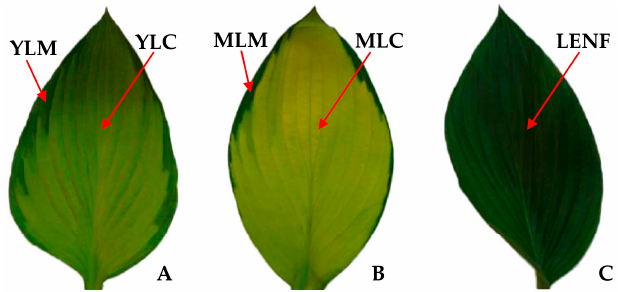
Figure 1. Representative leaves at different development stages of Hosta “Gold Standard”. ( A ) Young leaf; ( B ) mature leaf; ( C ) leaf under excess nitrogen fertilization. YLM: Young leaf margin; YLC: Young leaf center; MLM: Mature leaf margin; MLC: Mature leaf center; LENF: Leaf under excess nitrogen fertilization.